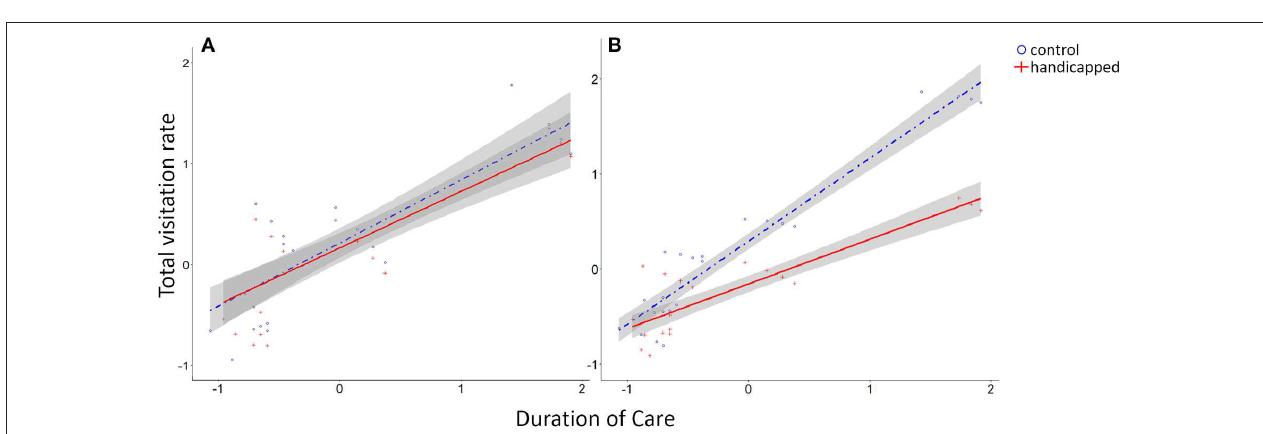
FIGURE 2 | Percent difference between nests with handicapping vs. control treatments in the post-treatment feeding rates of the focal individual and their partners for each species.